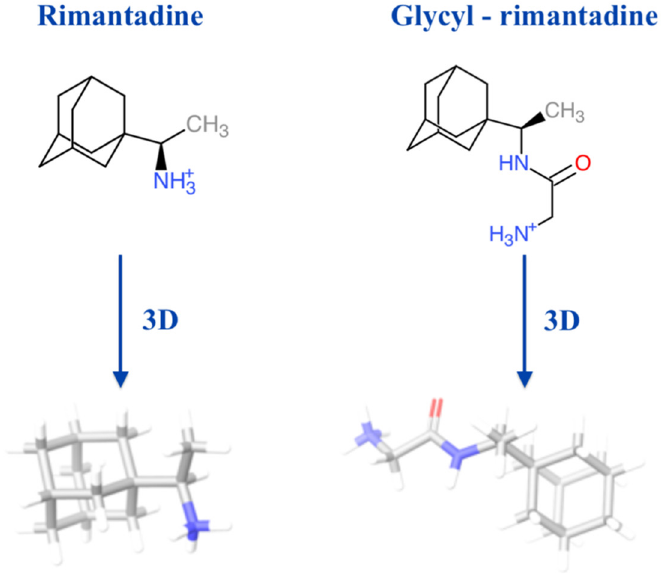
Figure 4. The two-dimensional (2D) and three-dimensional (3D) structures of rimantadine and glycyl-rimantadine ( 4b ).